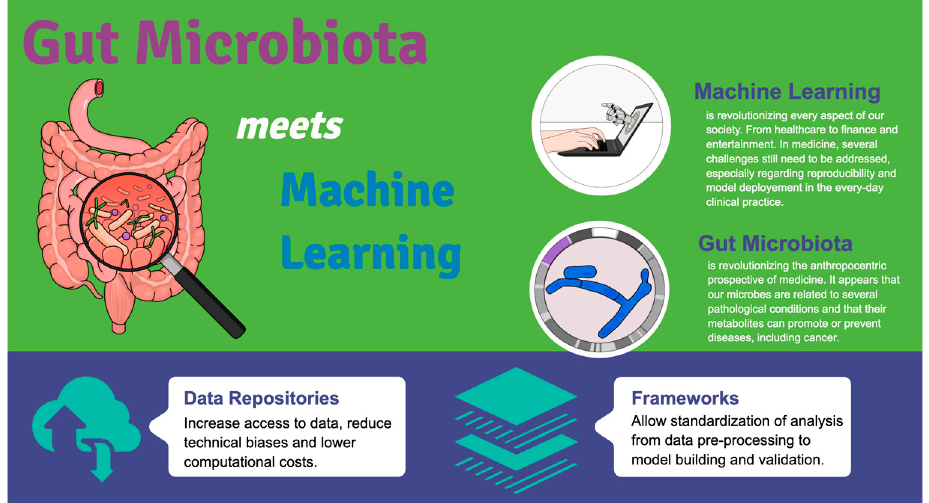
Figure 1. Gut Microbiota meets machine learning. The increasing data availability due to omics analysis has not been followed by the creation of data repositories, guidelines, and analytical frameworks in the past, which resulted in unsatisfactory reproducibility and reliability. The implementation of such tools has facilitated a shift in the field from observational association studies to experimental causal inference and clinical intervention.